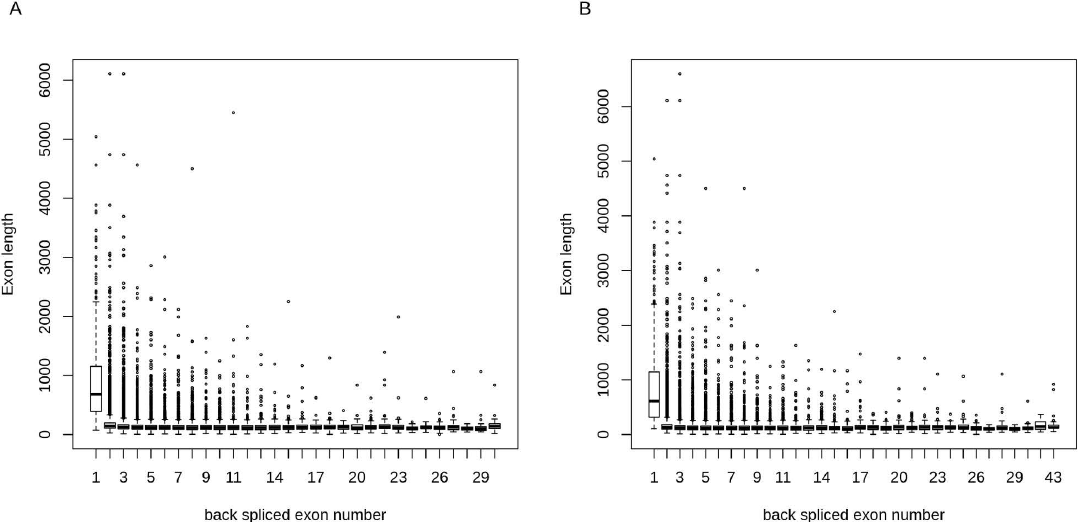
Figure 3. Exon lengths of circRNAs in α - and β -cells. circRNAs with single exons had longer exon lengths in both ( A ) α -cells and ( B ) β -cells as compared to circRNAs with multiple